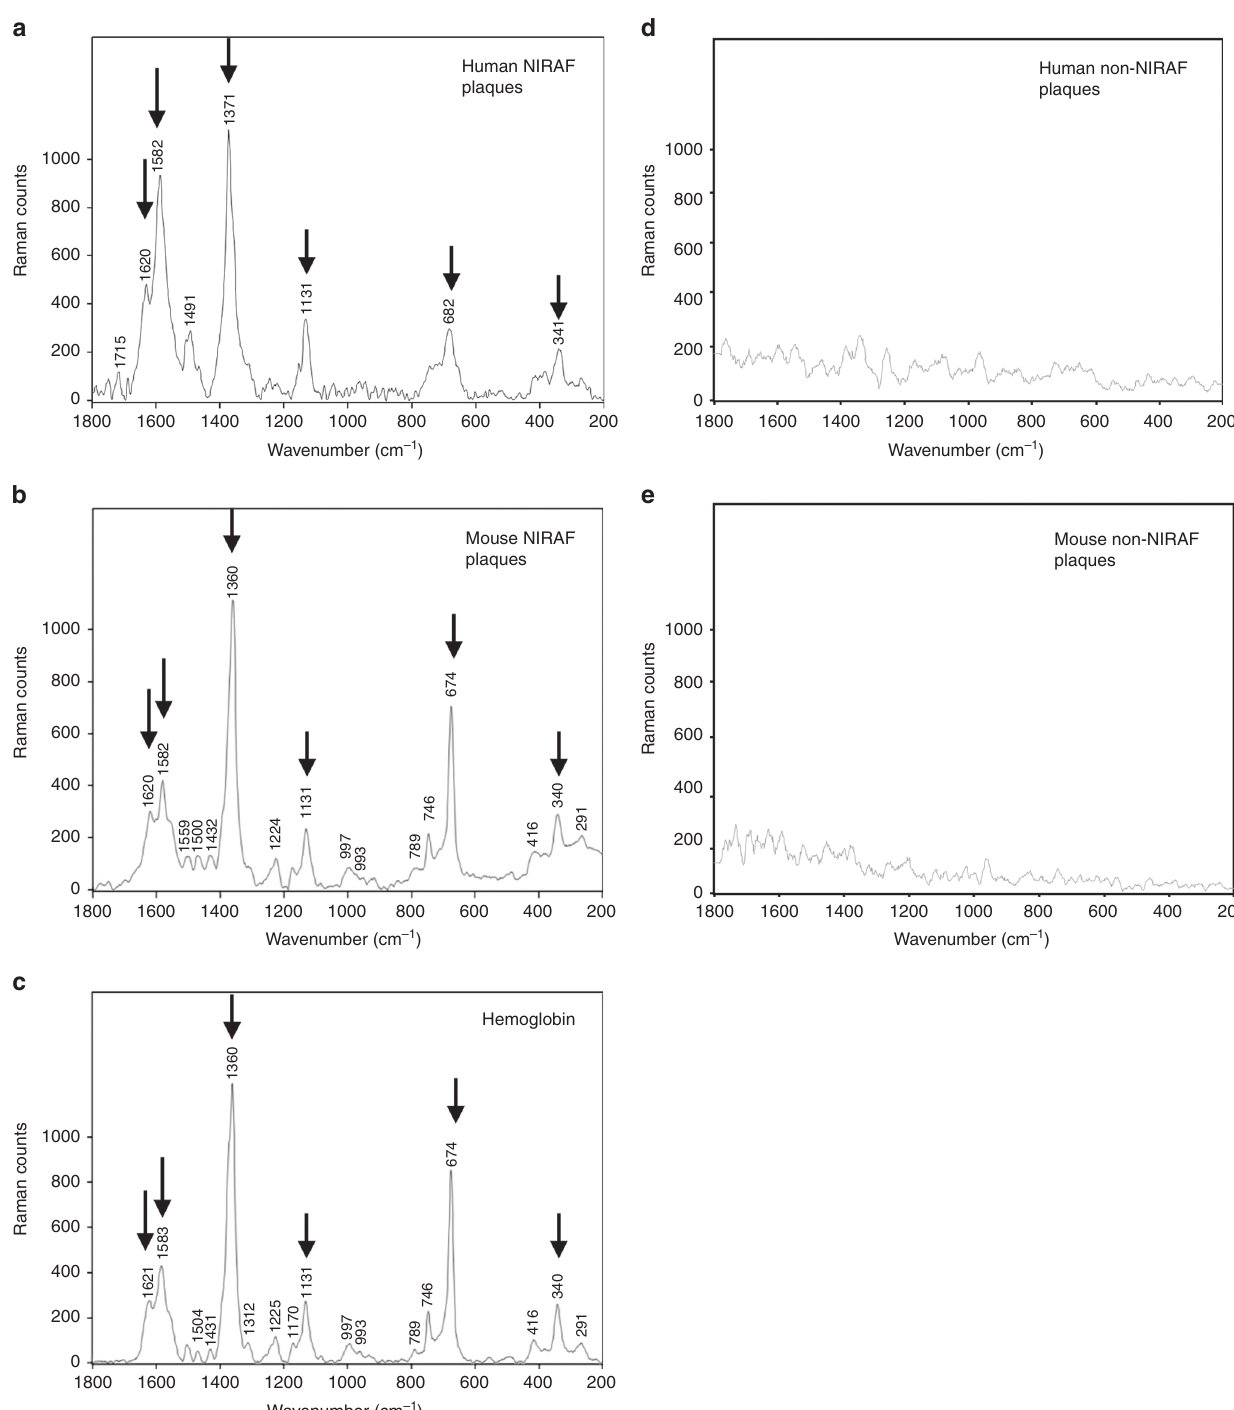
Fig. 3 Raman signals obtained from human and murine carotid plaques with or without NIRAF. a Raman signals from a NIRAF human CEA sample (5 µ m cryosection) showing the oxidation state marker band ν 4 at 1371 cm − 1 assigned to a symmetric pyrrole half-ring stretching vibration consistent with the Fe ion being in the ferric state associated with oxygenated hemoglobin. b Raman spectra from NIRAF murine carotid sample (40 µ m cryosection). The spectra of the plaques appear to show a mixture of heme products as evidenced by the position of ν 4 , which appears at 1360 cm − 1 indicative of ferrous heme but also shows a shoulder feature at ~1371 cm − 1 , which is associated with ferric heme indicating a mixture of oxygenated and deoxygenated hemoglobin. In oxygenated hemoglobin, which is in the ferric low spin state, this band normally appears between 1376 and 1370 cm − 1 . In deoxygenated hemoglobin, where the Fe ion is in the ferrous high spin state, this band normally appears between 1360 and 1350 cm − 1 . A number of other strong heme bands are observed in the spectra of the plaques. These include bands at 1620 cm − 1 , 1582 cm − 1 , 1544 cm − 1 assigned to C = C and C – C bonds of the porphyrin backbone a , b . c Raman signals obtained from hemoglobin demonstrated almost identical peaks with murine NIRAF plaques at 1620, 1582, 1360, 1311, 1225, 789, 674, 416, 340, and 291 cm − 1 . d Raman signals from a human non- fl uorescent plaque and e Murine non- fl uorescent plaques demonstrated no speci fi c chemical fi nger prints. Arrows indicate the major heme